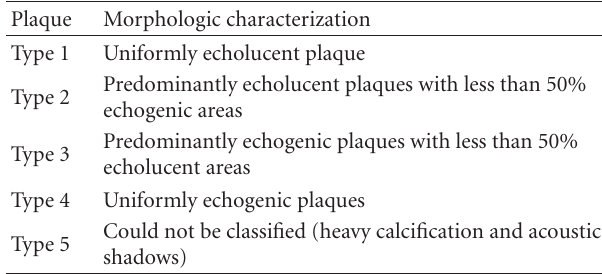
Table 2: Nicolaides plaque